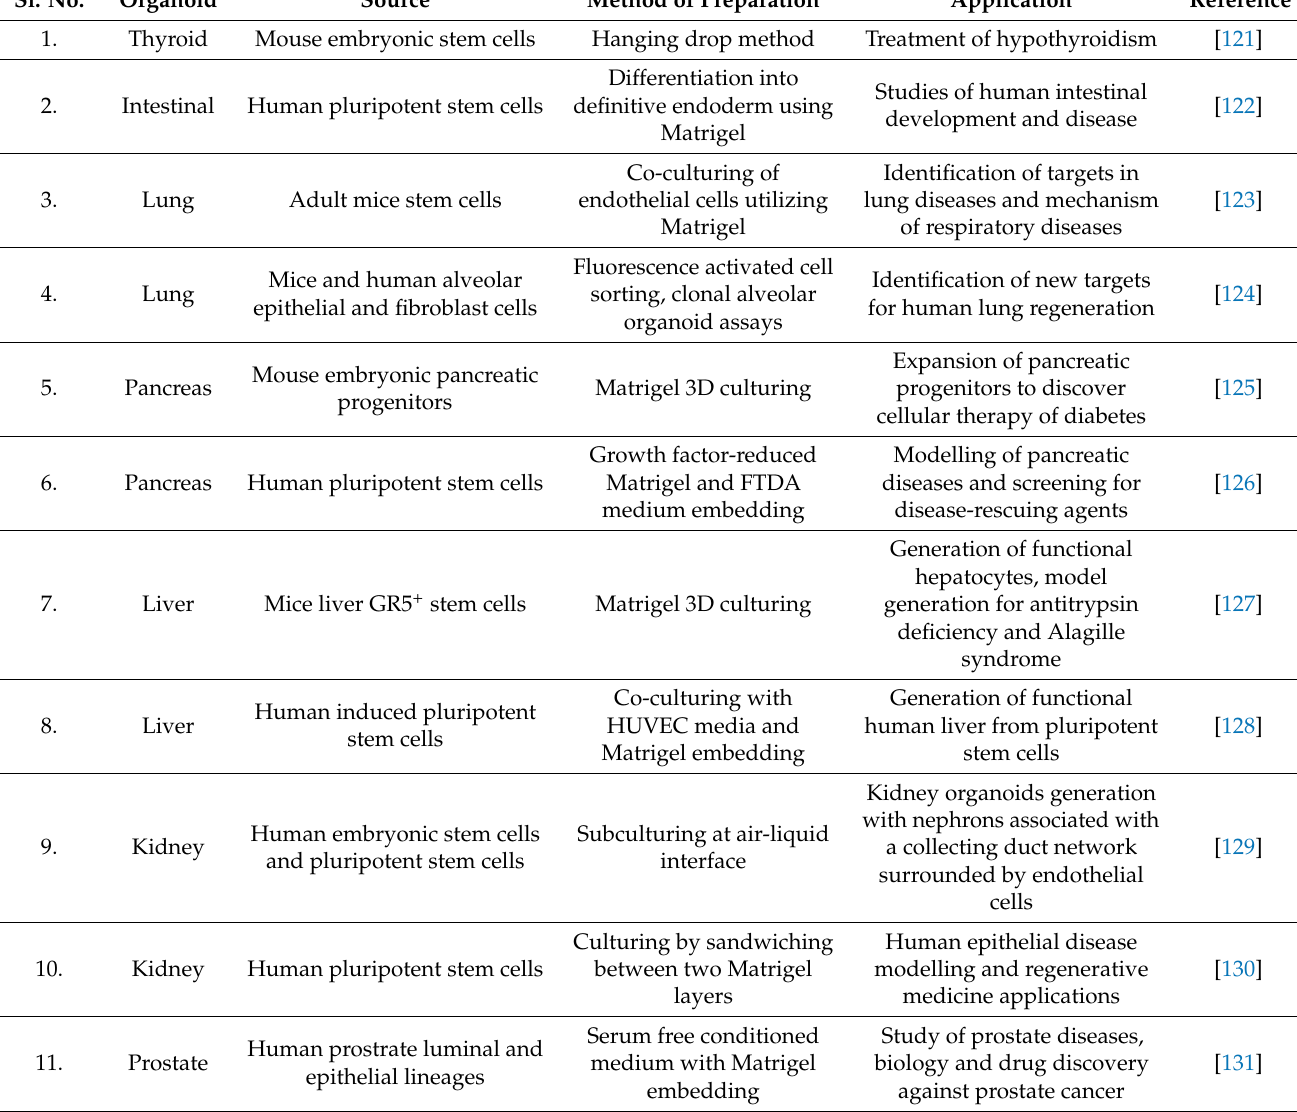
Table 5. Contribution of some reported